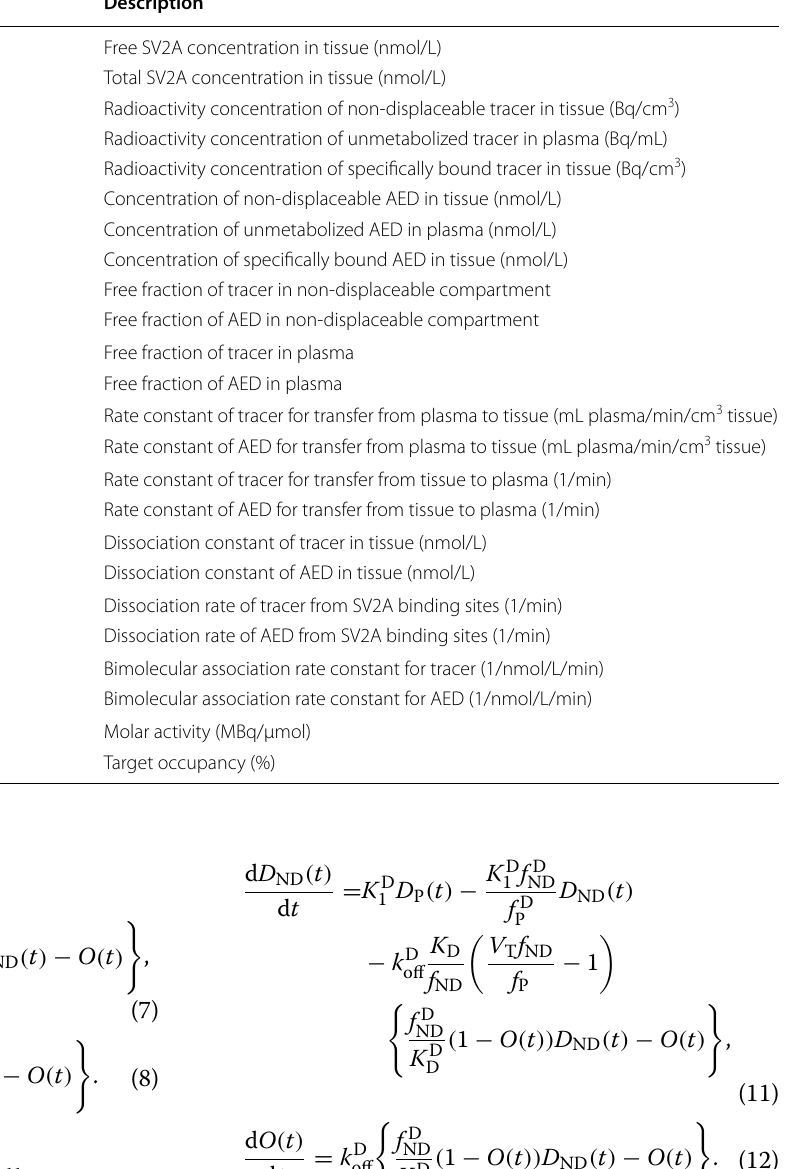
Table 1 Variables and functions and descriptions Variables and functions